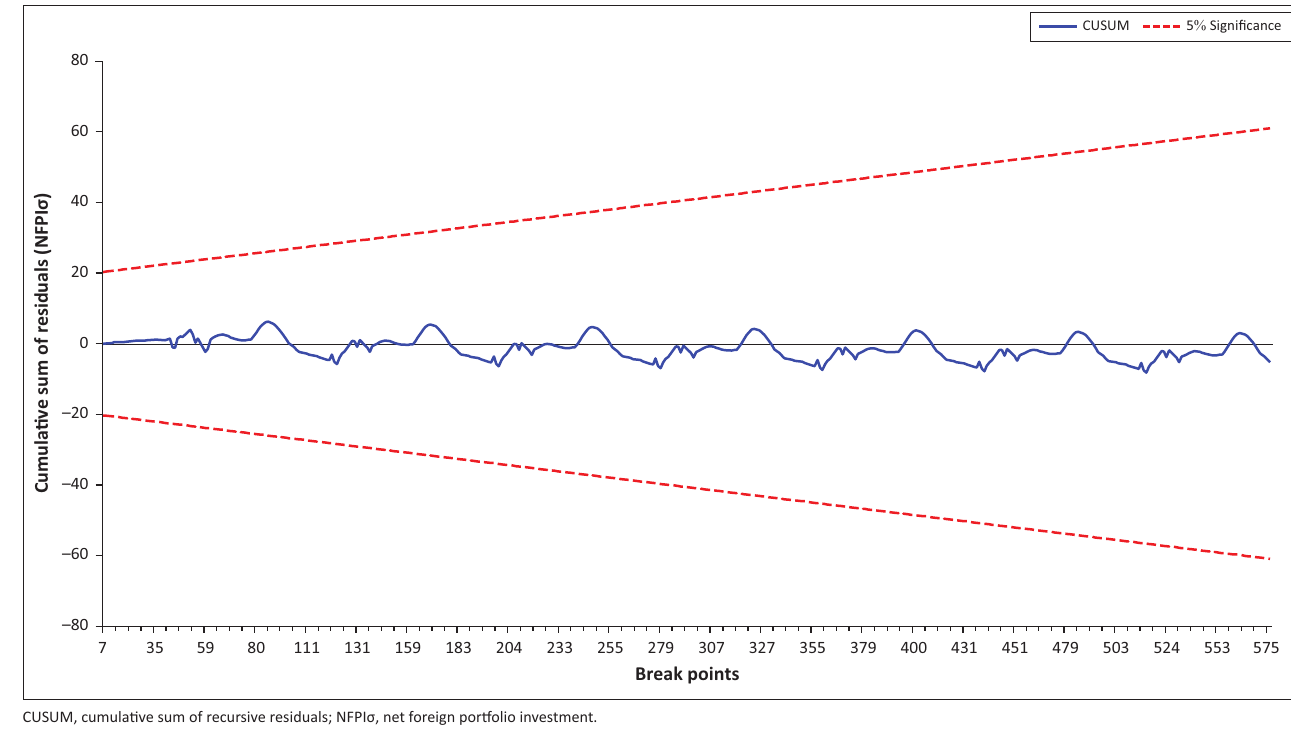
FIG URE 3: Possible number of panel ARDL (autoregressive distributed lag) models using the Akaike Information Criteria.